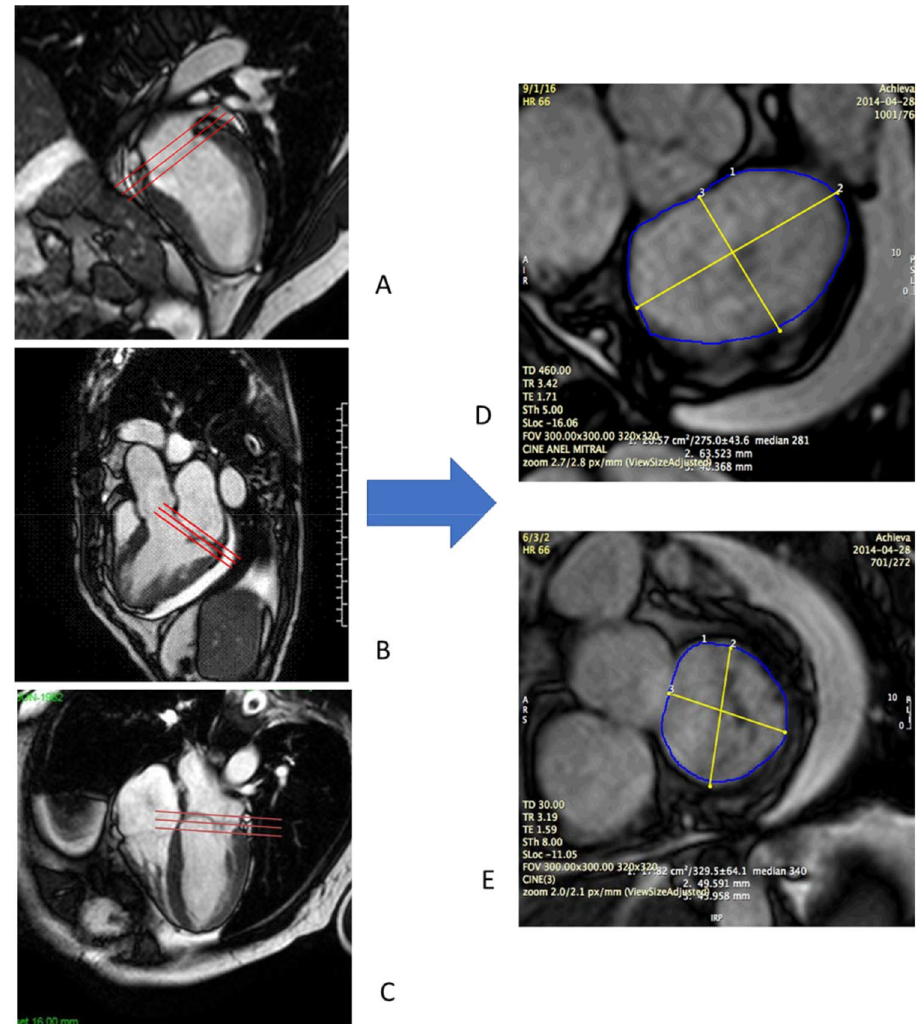
Figure 1 - Acquisition of mitral valve images by CMR. We used three images for visualization of the mitral valve on the long axis, with images in two chambers (A), 3 chambers (B) and four chambers (C). Mitral valve insertion points were visualized in all of them and used as parameters to obtain an adequate alignment and to derive the images on the short axis of the mitral valve in systole (D) and diastole (E).